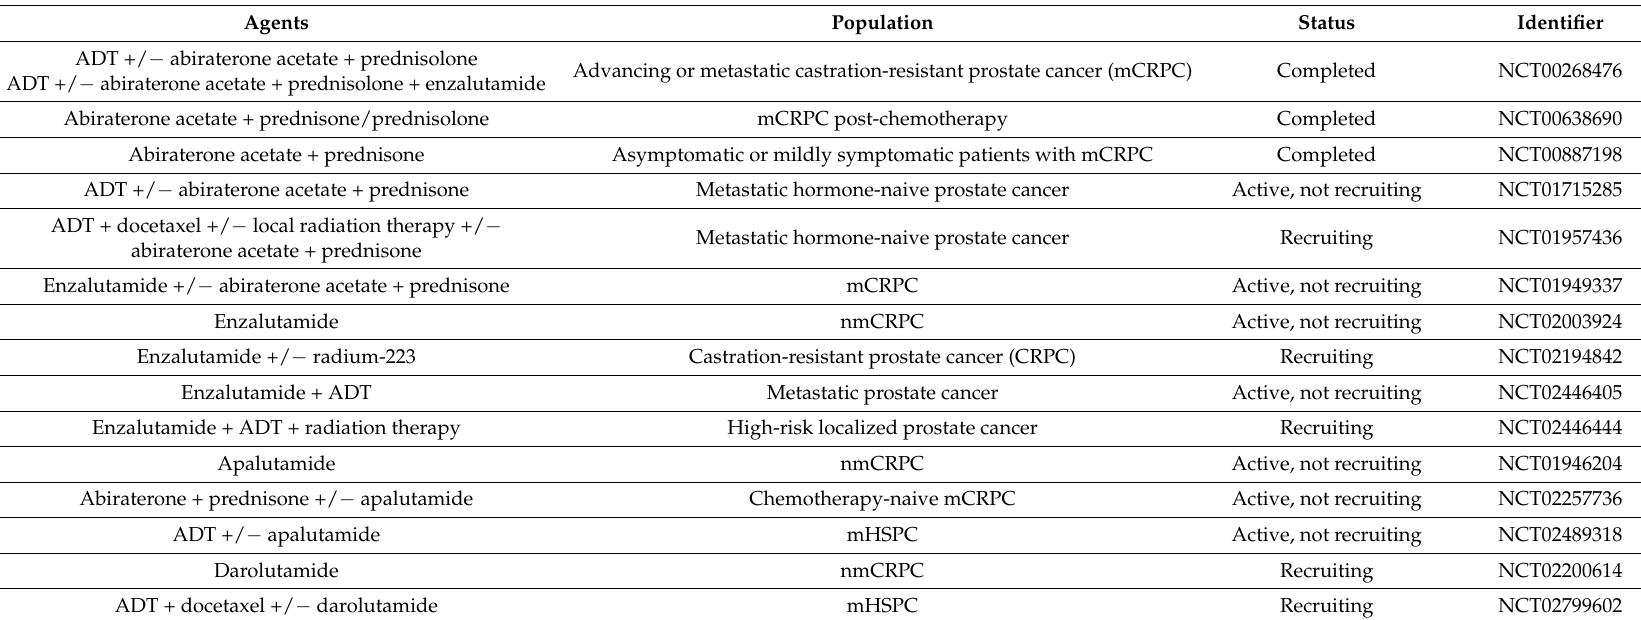
Table 1. Selected phase 3 clinical studies in prostate cancer with drugs addressing the AR pathway. Source: https://clinicaltrials.gov/. Agents